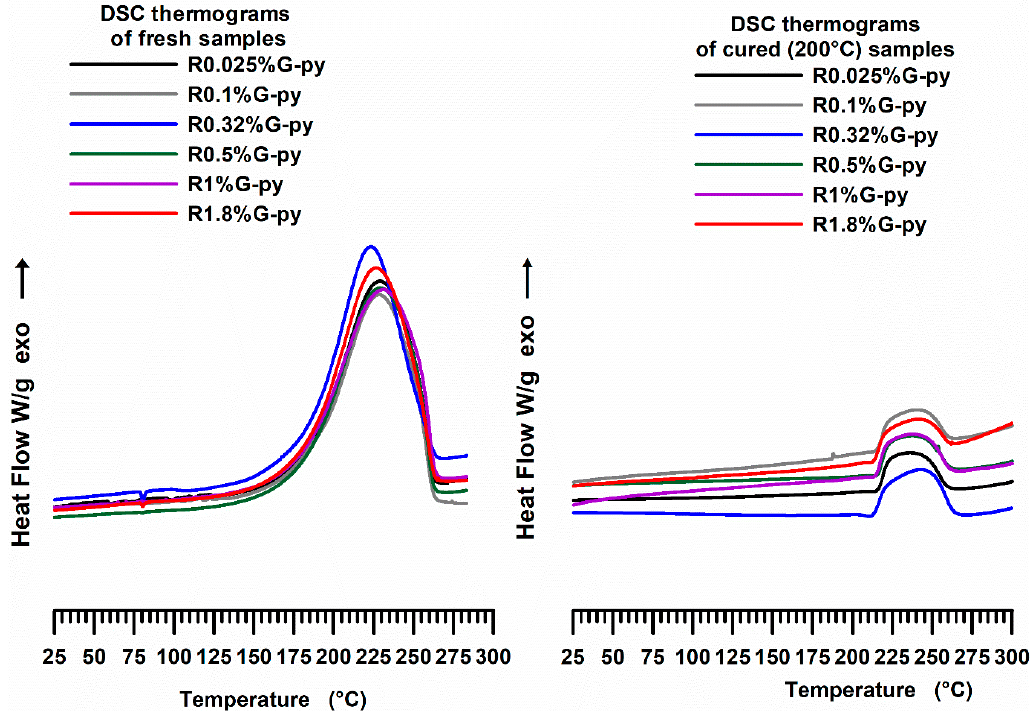
Figure 15. DSC curves of the epoxy formulations (fresh—first run and cured at 200°C—second run) containing different G-py weight percentages.